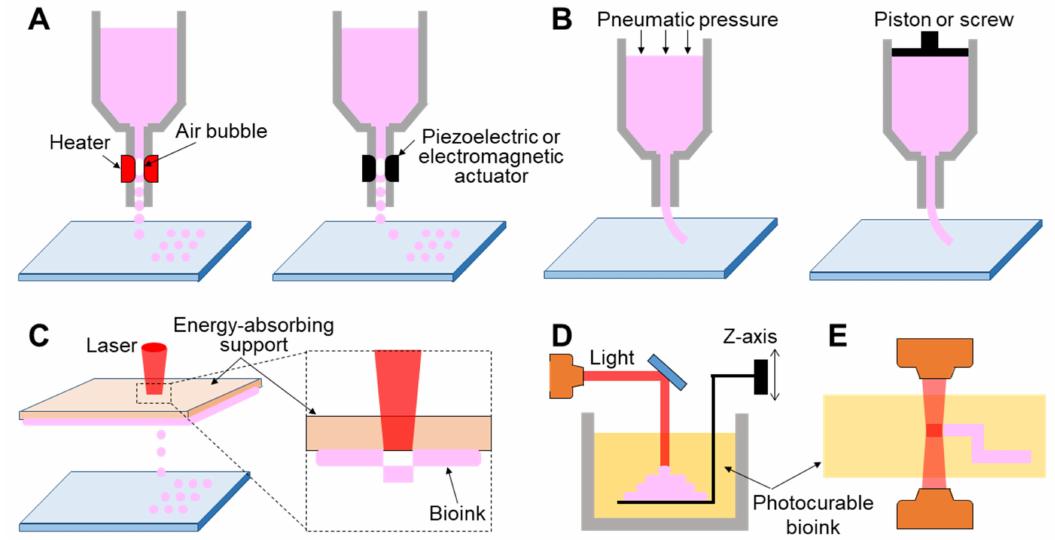
Figure 2. Schematic illustration showing printing strategy. ( A ) Inkjet-based 3D printing, ( B ) extrusion-based 3D printing, and light-assisted 3D printing, including ( C ) laser-induced forward transfer technique, ( D ) stereolithography, and ( E ) photon polymerization